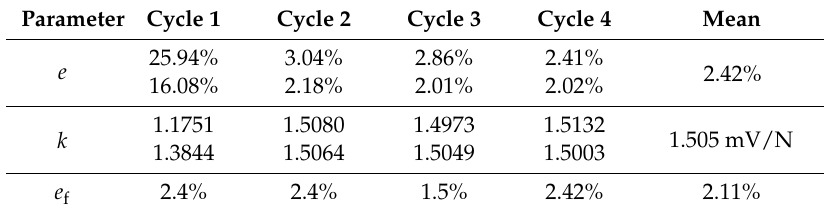
Table 1. The linearity ( e ), sensitivity ( k ), and repeatability ( e f ) of the PZTCC under cyclic loading. Parameter Cycle 1 Cycle 2 Cycle